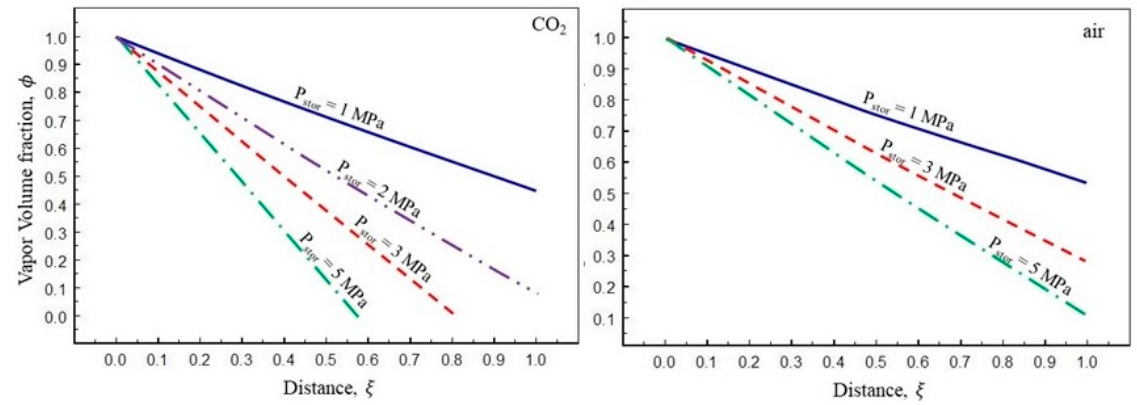
Figure 6. Effect of storage pressure on the volume fraction of the steam vapor (storage container temperature of 35 °C (308 K)).